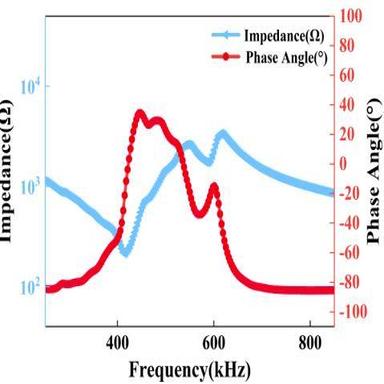
Impedance spectrum of an ultrasonic transducer bonded with a single matching layer.